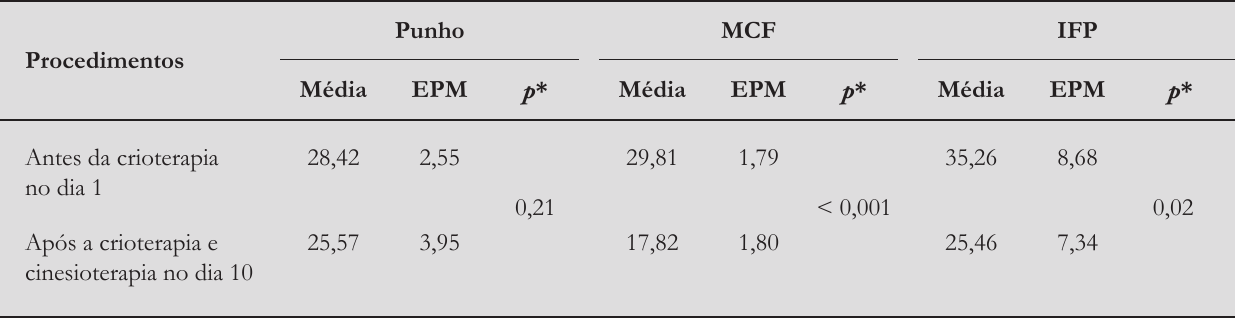
Tabela 2 - Valores das médias goniométricas de cada articulação (punho, metacarpofalangeas e interfalangeas) antes da crioterapia no primeiro dia de tratamento e após crioterapia e cinesioterapia no décimo dia de tratamento (n=7)